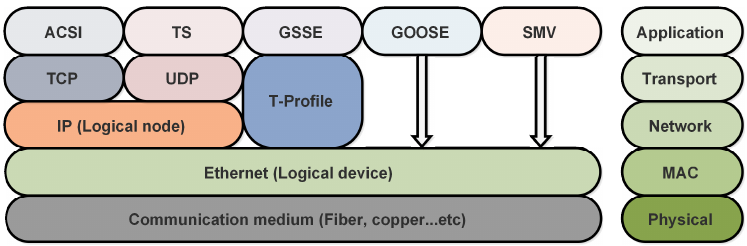
Figure 5. IEC 61850 communication stack